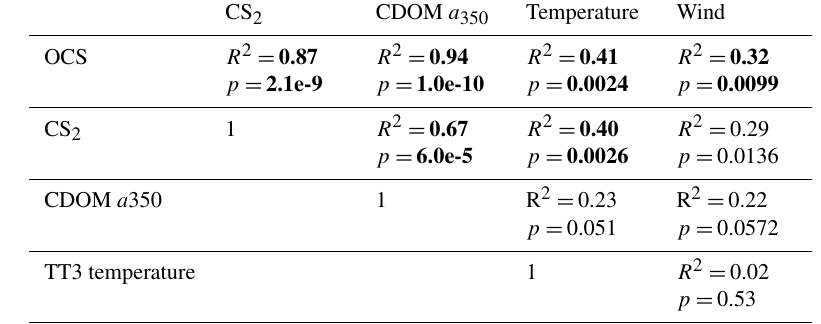
Table 3. Explained variance (Pearson’s R 2 ) and significance level p for correlations of globally integrated emissions for OCS and CS 2 with global annual averages of CDOM a 350 , skin temperature, and wind speed. Significant results ( α = 0 . 01) are indicated in bold font.